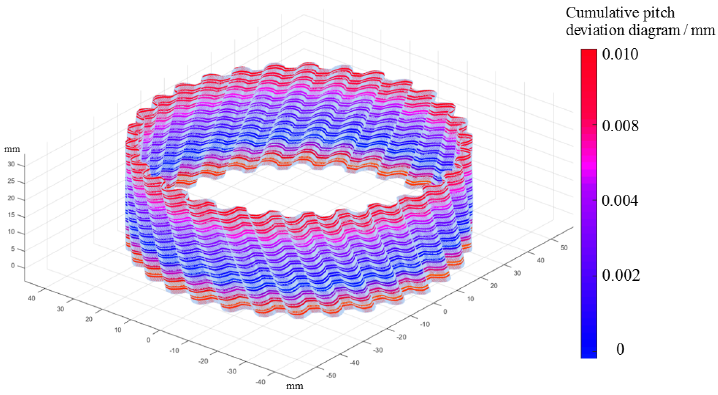
Figure 16. Color map of the pitch deviation on the gear section.